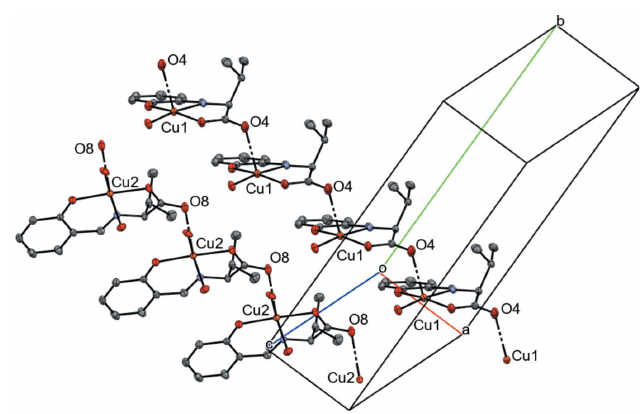
Figure 3 The chains resulting from the coordination bonding of the carbonyl groups to the copper(II) atoms. Hydrogen atoms are omitted for clarity.